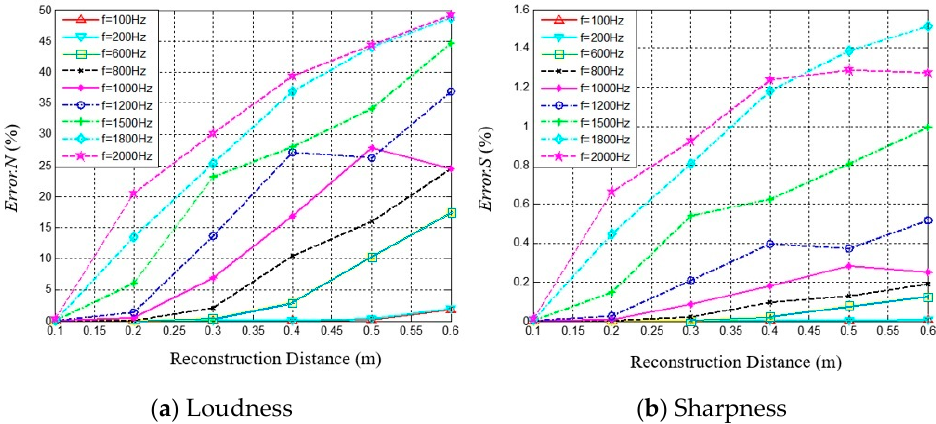
Figure 4. The variation of reconstruction errors of sound quality objective parameters with reconstruction distance at different sound frequencies. ( a ) Reconstruction errors of Loudness, ( b ) Reconstruction errors of Sharpness.